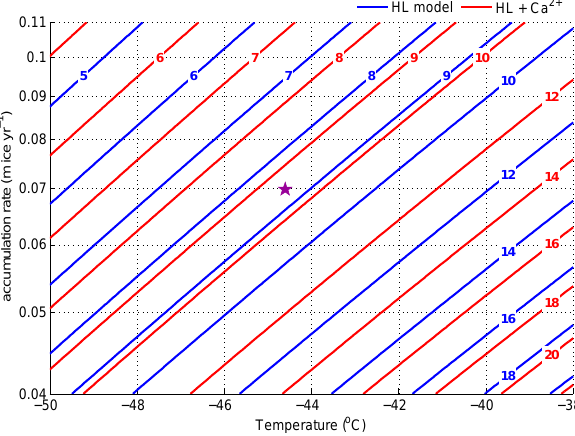
Figure 8. Contour lines of the squared differential diffusion length (incm 2 ) as a function of firn temperature and accumulation rate for the EDML ice core site. Values for (cid:49)σ 2 at pore close-off are calcu- lated with the classical HL model (blue lines) and with the modified HL model. For the latter a Ca 2 + concentration of 2.2ppb is used, which corresponds to the average concentration in the 123–289m depth interval of the EDML ice core. (cid:49)σ 2 is given in ice equiva- lents assuming a thinning of 1. The star indicates the present-day temperature and accumulation rate at the drill site. Note that the accumulation rate is plotted on a log